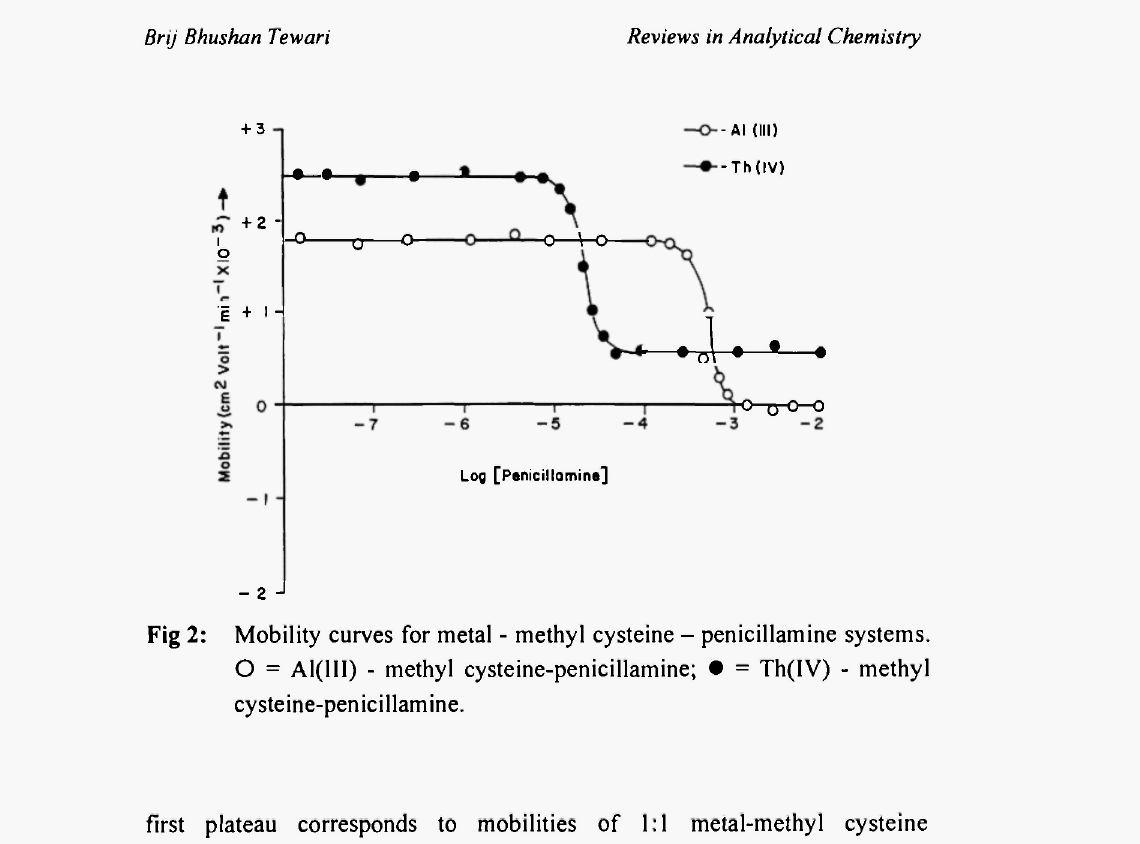
first plateau corresponds to mobilities of 1:1 metal-methyl